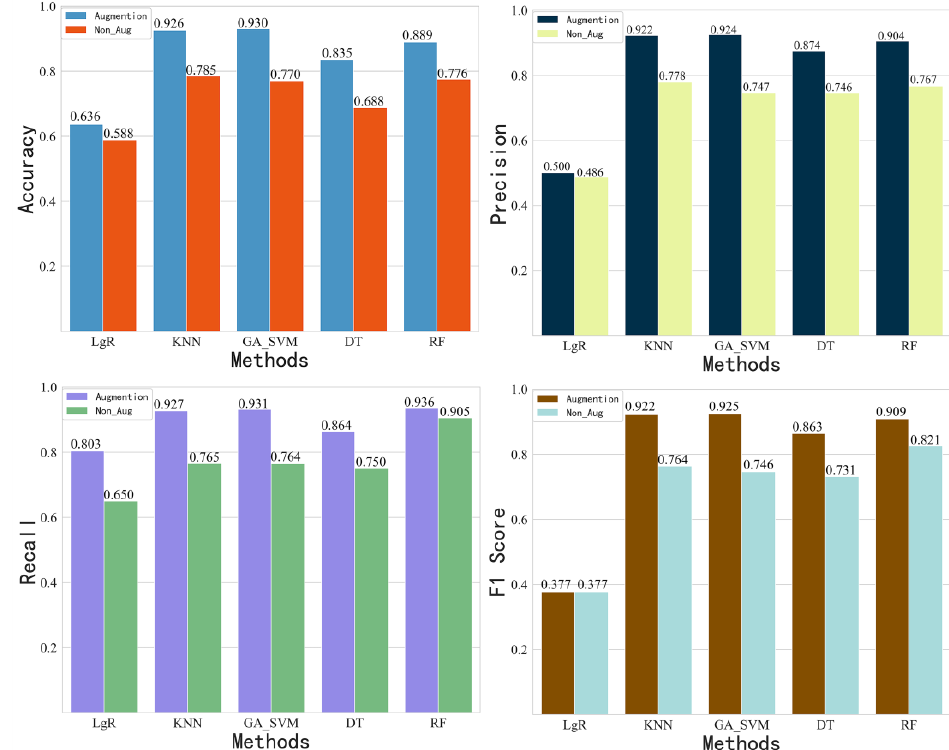
Figure 15. Impact of data augmentation techniques on the performance of the different machine learning algorithms.